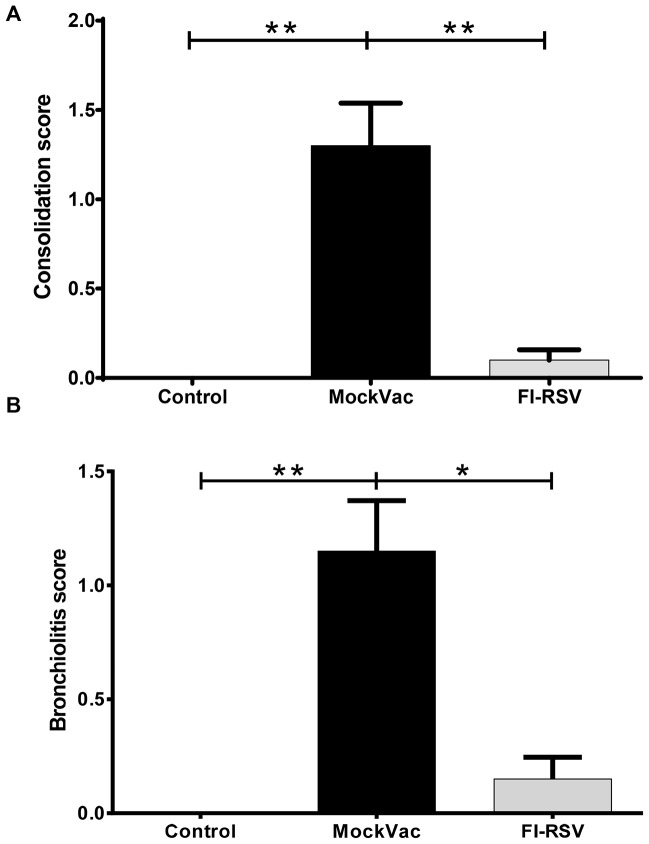
Histopathologic lesions of consolidation (A) and; bronchiolitis (B).Controls lacked lesions while mock-vaccinated (MockVac) lambs had significantly increased consolidation and bronchiolitis scores compared to lambs vaccinated with FI-RSV. Control n = 4; MockVac n = 4; FI-RSV n = 4. Error bars = SEM, *P<0.05, **P<0.01.